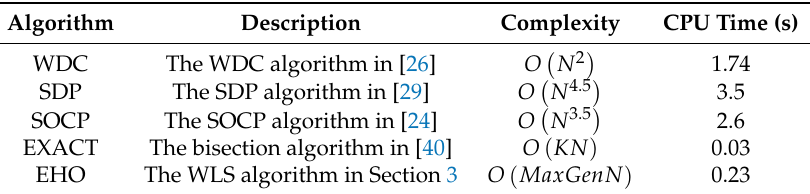
Table 2. Summary of the Considered